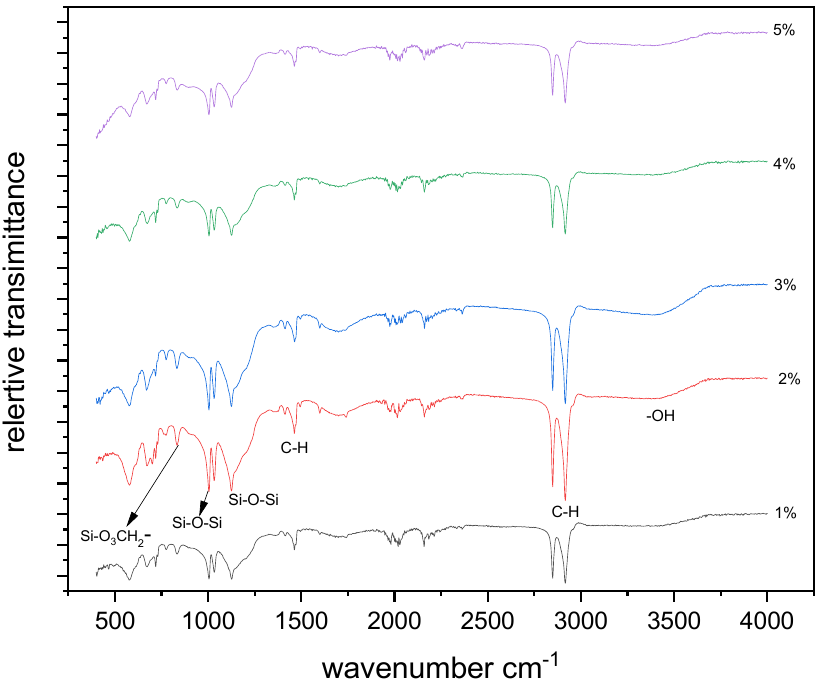
Figure 12. FT-IR spectrum of PE-g-PS-based composite with GF treated by different 3-MPS concentrations.